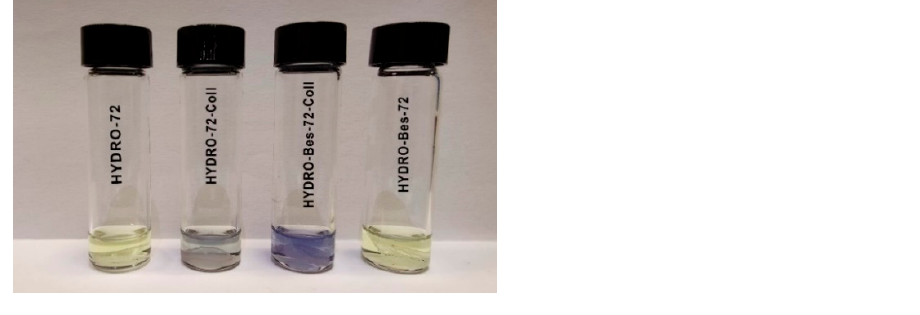
Figure 3. Images of ninhydrin test carried out on HYDRO-72, HYDRO-72-Coll, HYDRO-Bes-72-Coll, and HYDRO-Bes-72 dry samples.